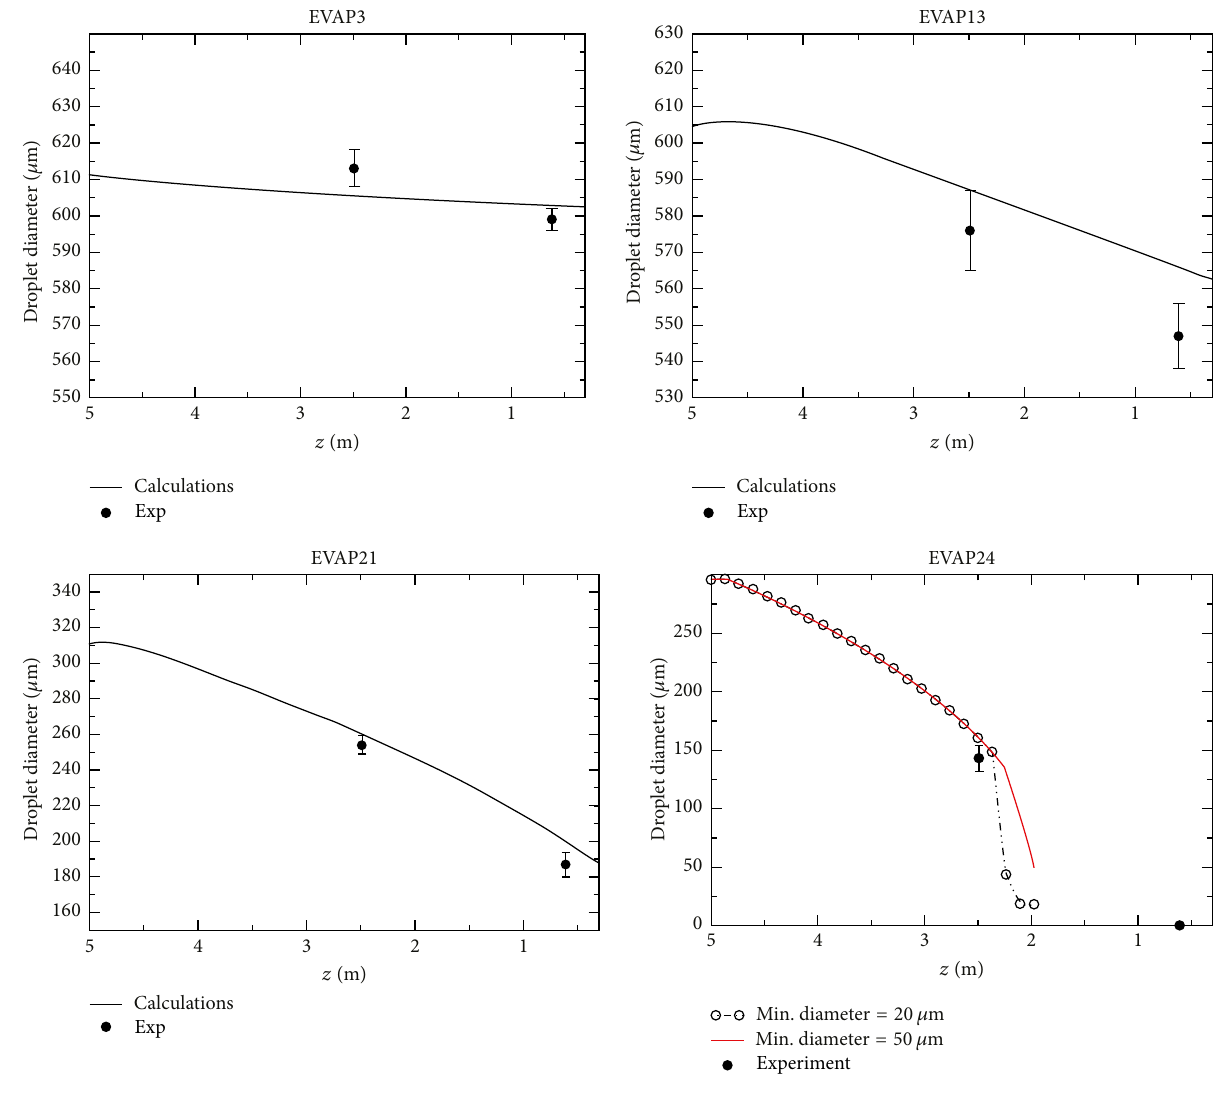
Figure 17: Droplet diameter versus elevations, evaporation cases.